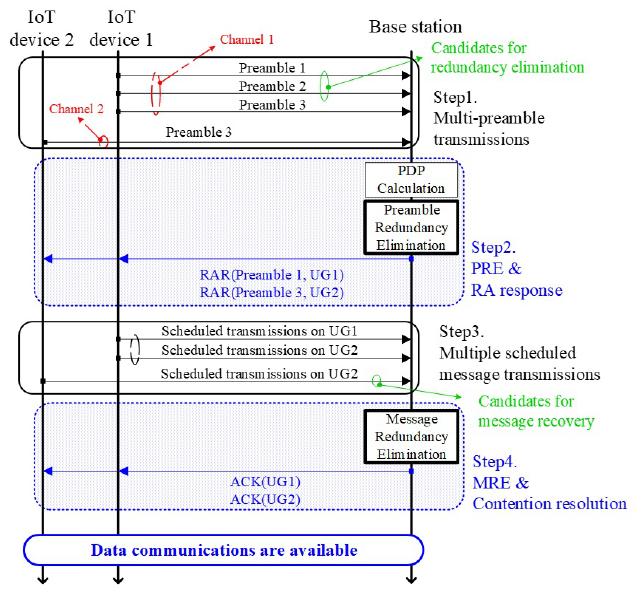
Figure 4. Overall procedure of our proposed technique: Two IoT devices are attempting their RAs with different k value (i.e., k = 3 and k = 1 for IoT device 1 and 2, respectively), and two redundancy elimination mechanisms are applied at the BS.